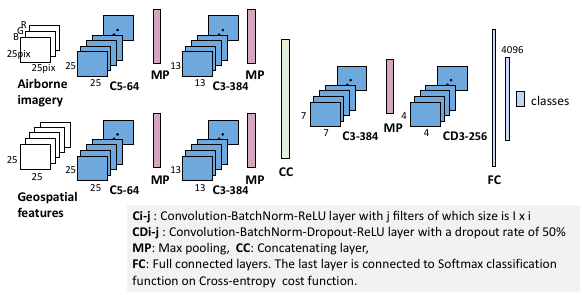
Figure.3 Base architecture of multi-modal CNN